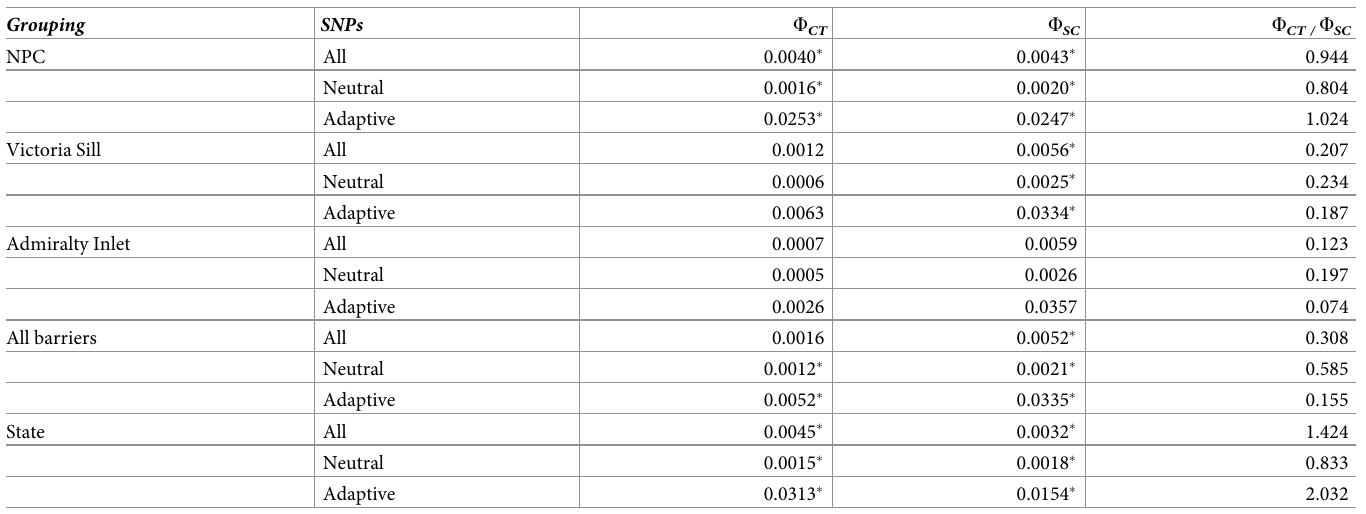
collection site pairings with the small collection from Auke Bay, AK (Table 1). Only one pair- wise site comparison (Keyport and Eld Inlet, WA) yielded a pairwise F value that contained ST 0 in the 95% confidence interval (Table J in S1 File). The largest pairwise F values were ST found among collection sites from the northern (Alaska and British Columbia) and southern (Washington and Oregon) parts of the species range ( F = 0.005–0.015). Notably, pairwise ST differentiation between collection sites within Washington was broader in range and at times greater than that within Alaska, despite substantially smaller in-water distances (mean = 162 km , SD = 62 km in WA and mean = 731 km , SD = 339 in AK). Mean expected heterozygosity and proportion of polymorphic SNPs did not vary substan- tially across collection sites, apart from a reduced proportion of polymorphic SNPs in Auke Bay and Chiniak Bay, AK (Table 1). Observed heterozygosity decreased and F increased from IS Table 2. Results of hierarchical population structure, based on AMOVA